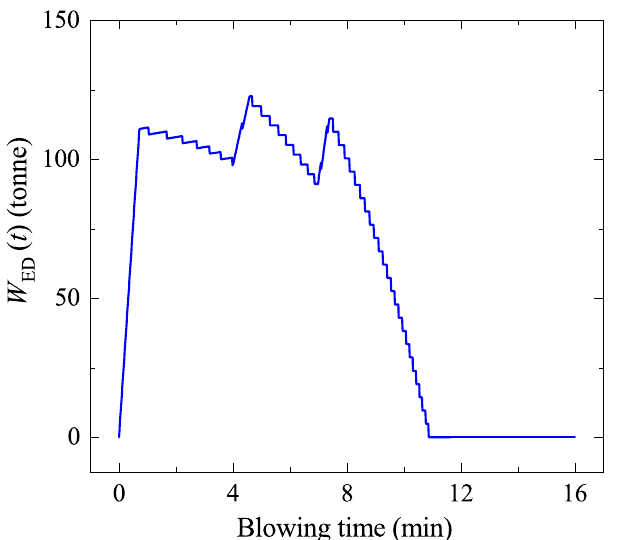
Figure 10. Mass of the ejected droplets staying in the emulsion ( W ED ( t ) ) as a function of blowing time.